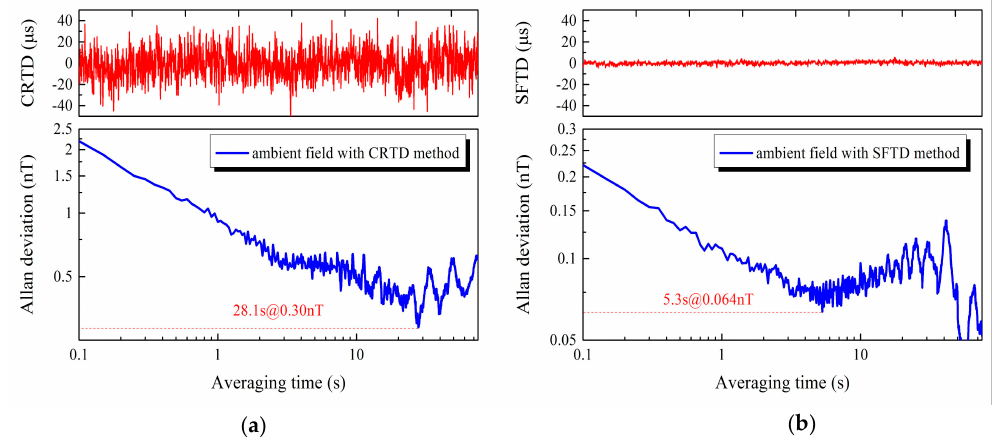
Figure 9. Raw RTD data and corresponding Allan deviation with different methods, ( a ) CRTD method ( b ) SFTD method, in which the excitation signal is 1 mA@20 Hz.